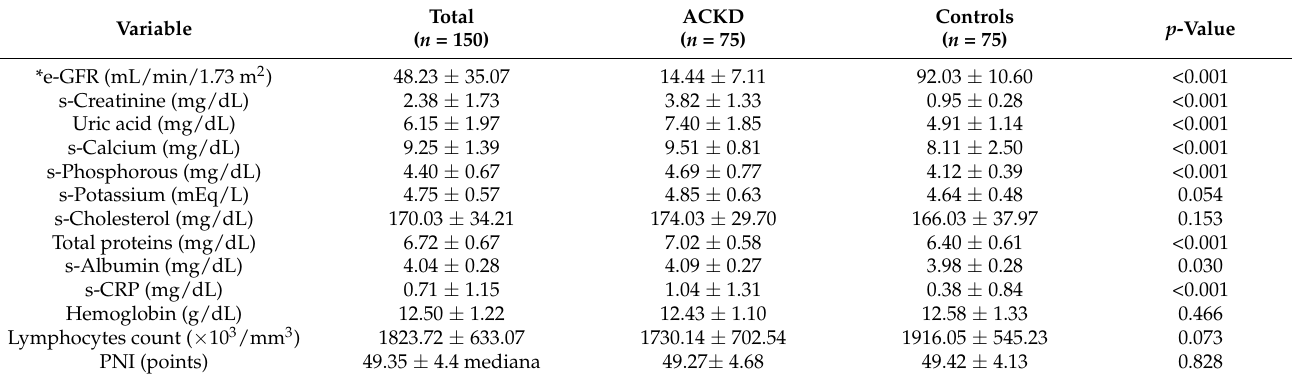
Table 2. Clinical and biochemical parameters characteristics of 150 participants in the study.